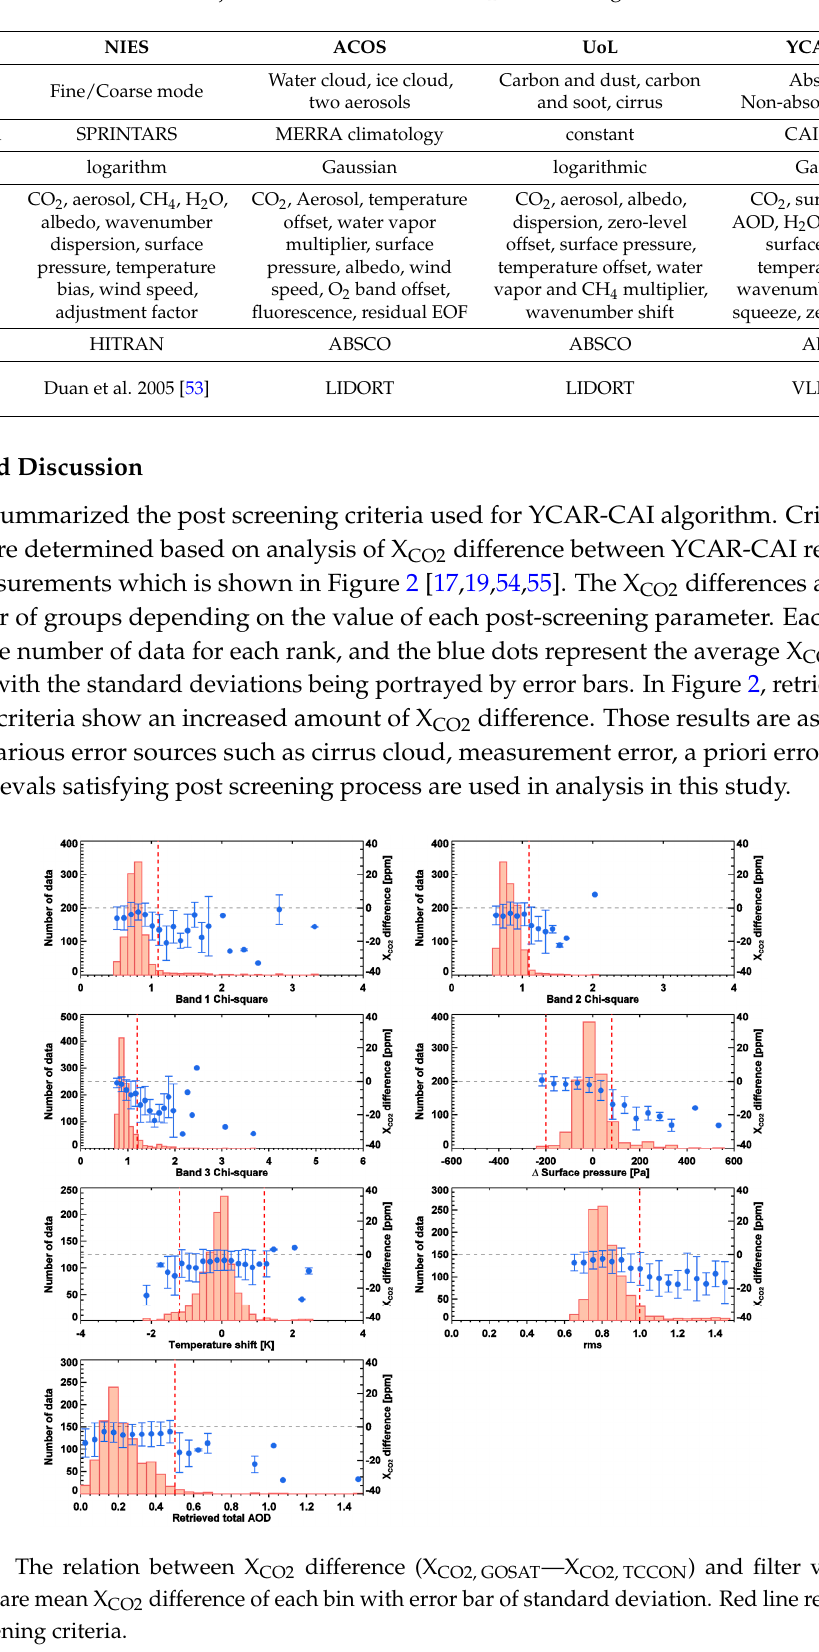
Table 3. Major differences between CO 2 retrieval algorithms.